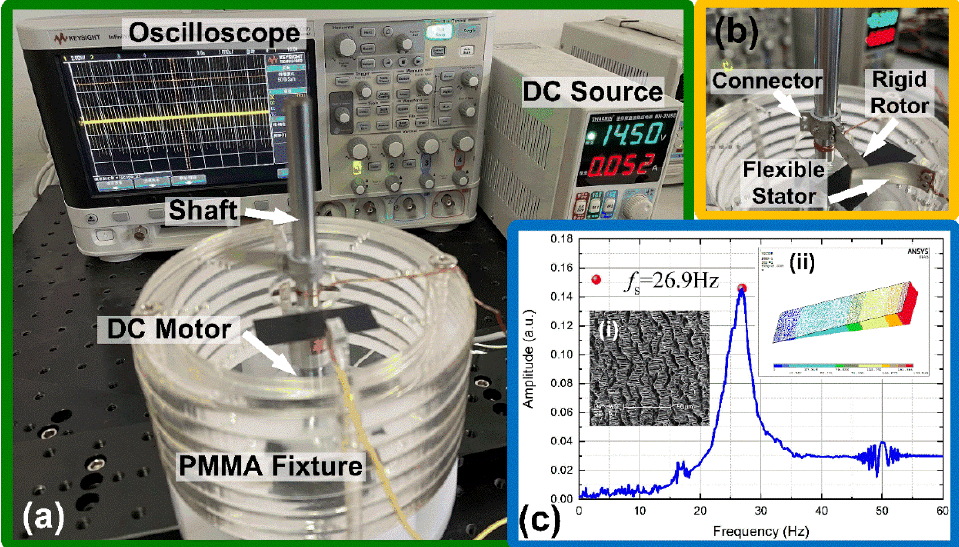
Figure 5. Experimental setup. ( a ) Photo of testing rigs; ( b ) Close-up photo of flexible stator and rigid rotor; ( c ) Frequency sweep test result of the flexible stator, showing resonant frequency of 26.9 Hz. Inset (i) in ( c ) is the scanning electron microscopy (SEM) photo of surface morphology of polytetrafluoroethylene (PTFE) film on the flexible stator, and Inset (ii) is the modal finite element analysis result of the flexible stator, showing theoretical resonant frequency of 28.33 Hz.